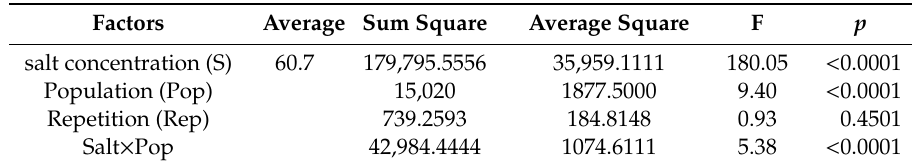
Table 2. Variance analysis for final germination percentage (FGP) of seven populations of M. ciliaris ( Pop1, Pop2, Pop3, 306, 355, 667, 773 ), compared to one population of M. intertexta ( M. int ) and one population of M. scutellata ( M. scut ).